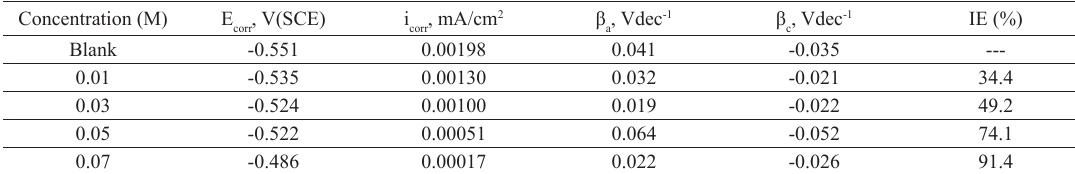
Table 1. Electrochemical corrosion parameters obtained from the polarization curves of mild steel in 0.5 M HCl solution with different concentrations of TTA (0 to 0.07 M). Concentration (M) E , V(SCE) corr